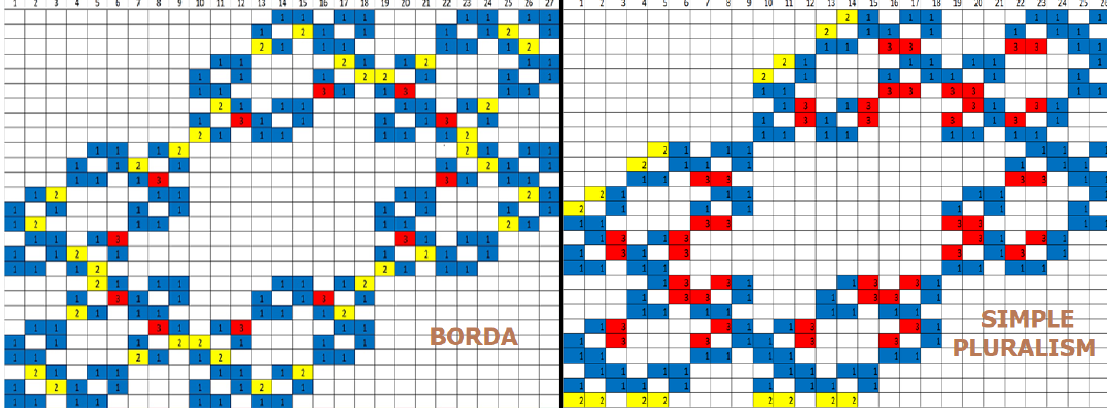
Figure 12. Comparison between the color maps (or heatmaps) for the Borda and simple pluralism methods for n = 3.